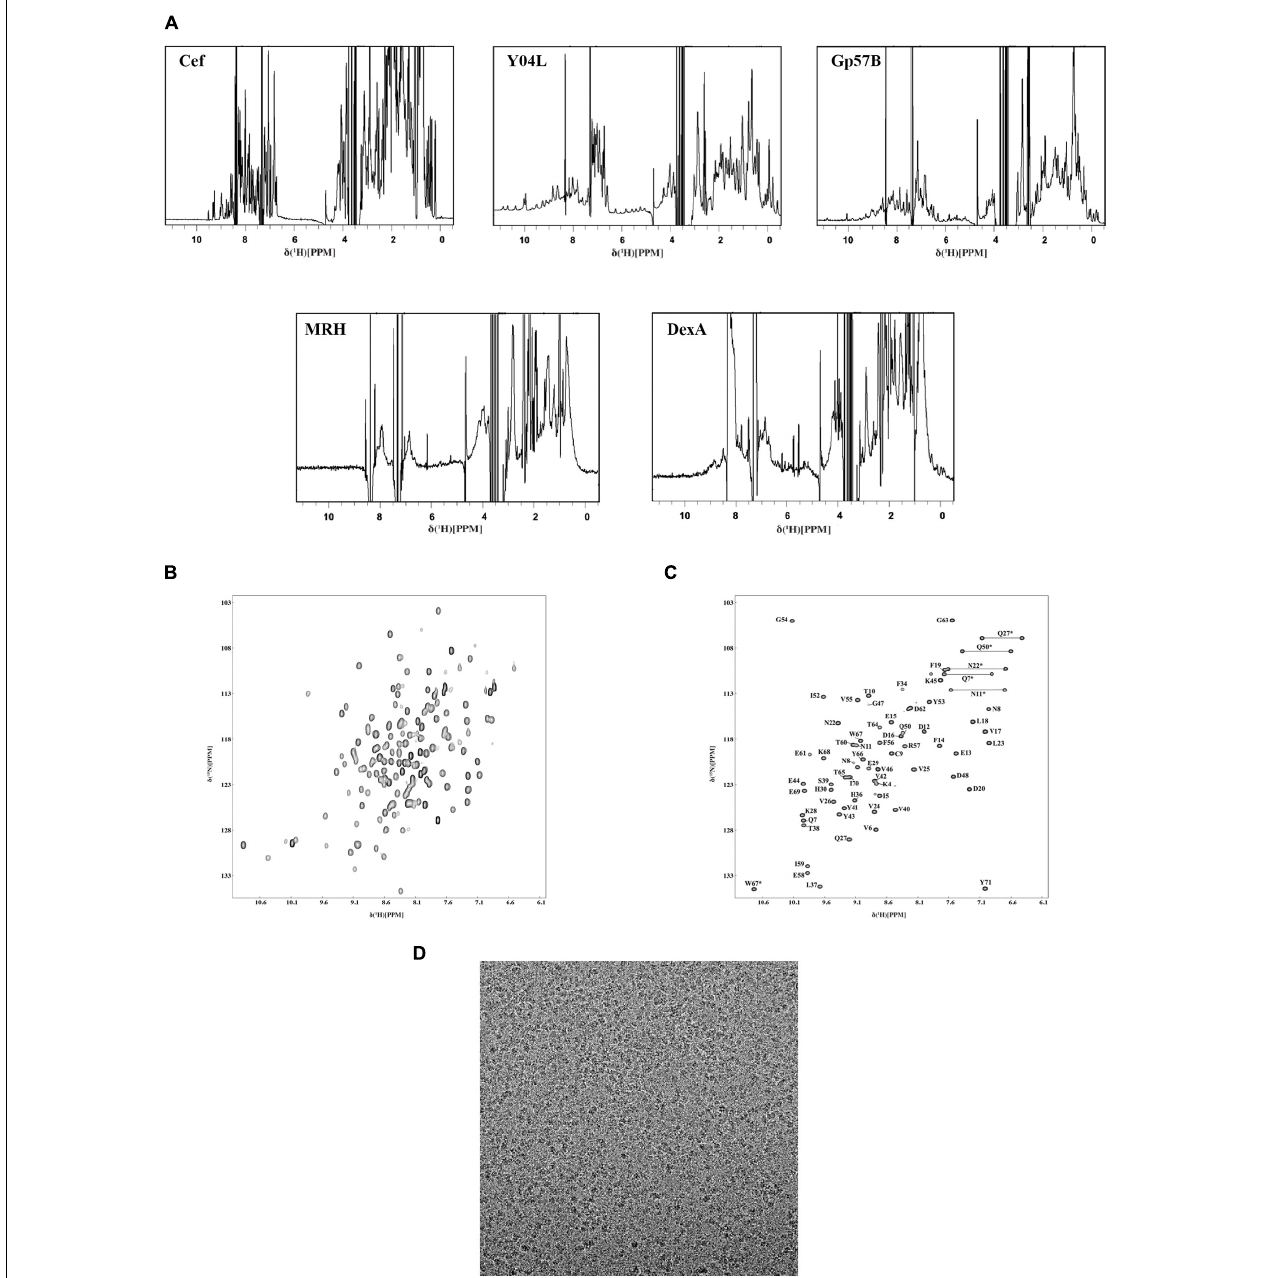
FIGURE 5 | Characterization of the soluble phage proteins using NMR and Cryo-EM. (A) 1D 1 H-NMR spectra of Cef, Y04L, and Gp57B showed characteristics of folded structural features, such as the presence of the sharp peaks below 1.0 ppm as well as the dispersion of peaks between 6.0 and 11.0 ppm. The 1 H-NMR spectra of MRH and DexA showed the characteristics of a large multimeric protein, such as broad peak caused by the higher molecular weight, which was in agreement with the size exclusion chromatograms of MRH and DexA. (B) The 2D 1 H- 15 N HSQC spectra of Y04L showed crosspeaks that were dispersed, indicating a folded structure in solution. (C) The assigned 2D 1 H- 15 N HSQC spectra of Cef showed crosspeaks that were dispersed, indicating a folded structure in solution. The crosspeaks were assigned with the corresponding amino acid number and type. (D) The representative motion-corrected cryo-EM micrograph of